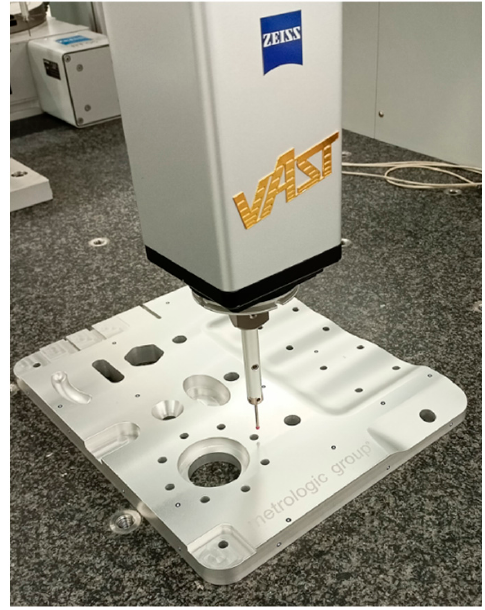
Figure 7. Dummy part calibration on the ZEISS UPMC 850 CARAT CMM.